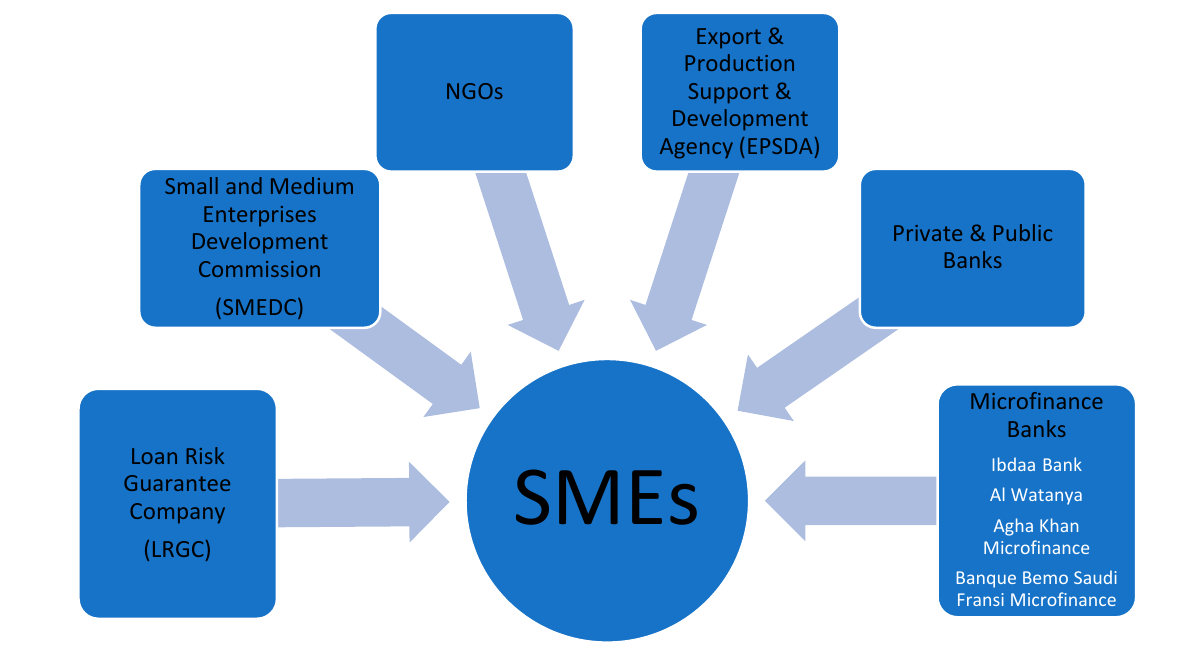
Figure 1. The ecosystem of SMEs in Syria.